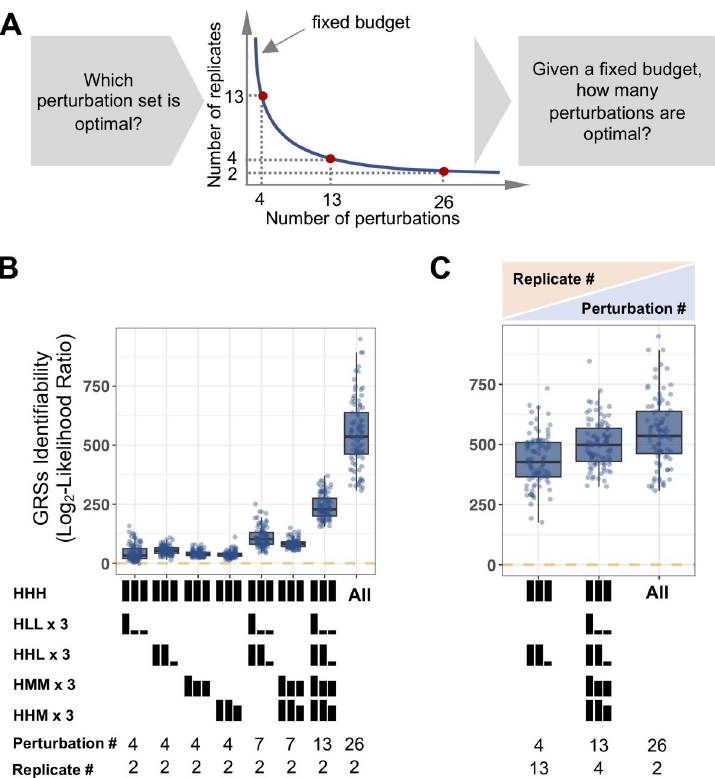
Fig 5. Principles of designing the experimental perturbation studies. (A) Schematic of the relationship between the number of replicates and perturbation conditions given a fixed budget to generate for example 52 datasets. (B) Effect of combining different perturbation sets on the identifiability (defined as the log2 likelihood ratio between the ground truth and the most similar alternative GRS) of the 93 GRSs. Testing 2 replicates for each condition, the number of perturbation sets determines GRS identifiability. Mathematically, we defined identifiability of each GRS as the lowest squared Euclidian distance between the gene expression responses of the ground truth GRS and any other GRS. (C) Comparison of the trade-off between the number of replicates and number of perturbation conditions for the identifiability of the 93 GRSs. When 52 datasets can be generated, employing more perturbation datasets is preferable to having more replicates for fewer perturbation